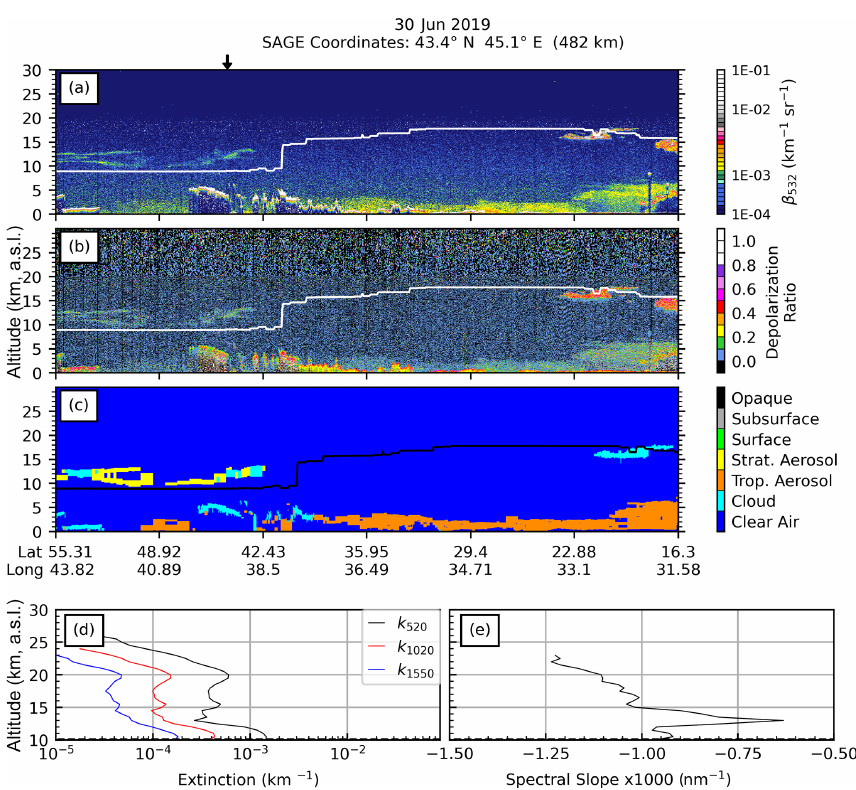
Figure 17. Smoke identified within an air mass that has yet to be impacted by the Raikoke eruption but was sampled within 8d of the Raikoke eruption. The CALIOP granule used to generate this image is